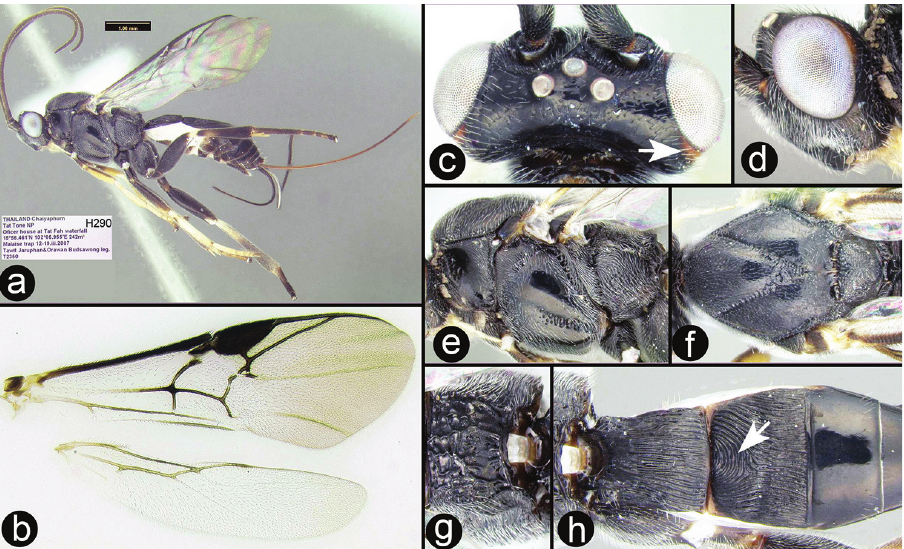
Figure 8. Cymagathis krikoma paratype female: a lateral habitus b wings c dorsal head, arrow indicating orange posterior orbit d lateral head e lateral mesosoma f dorsal thorax g propodeum h metasomal terga 1-3, arrow indicating semicircular carina on median tergite